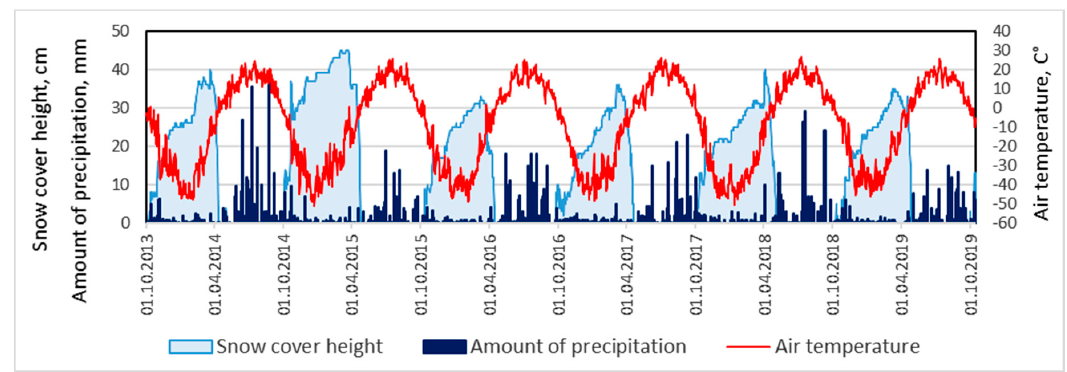
Figure 2. Annual variation in the air temperature, precipitation, and snow according to the weather station Churapcha.